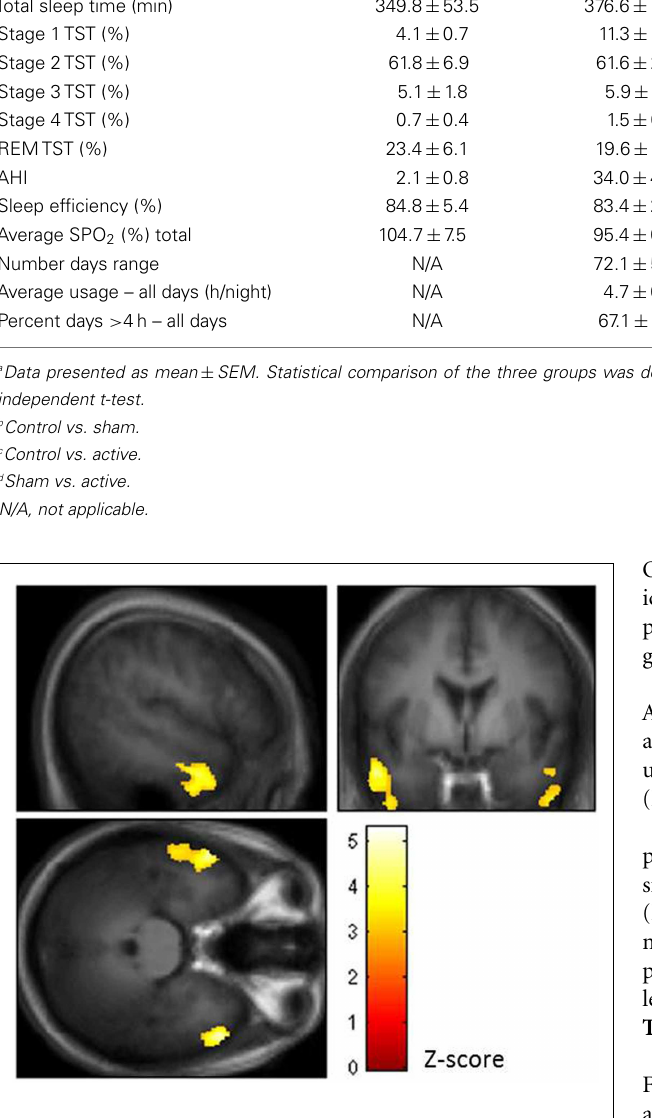
FIGURE 1 | Brain regions showing negative correlation between nocturnal hypoxemia duration and gray matter volume (GMV) in bilateral lateral temporal regions of the middle and inferior temporal gyri (BA = 20, 21) [topological false discovery rate (FDR) correction